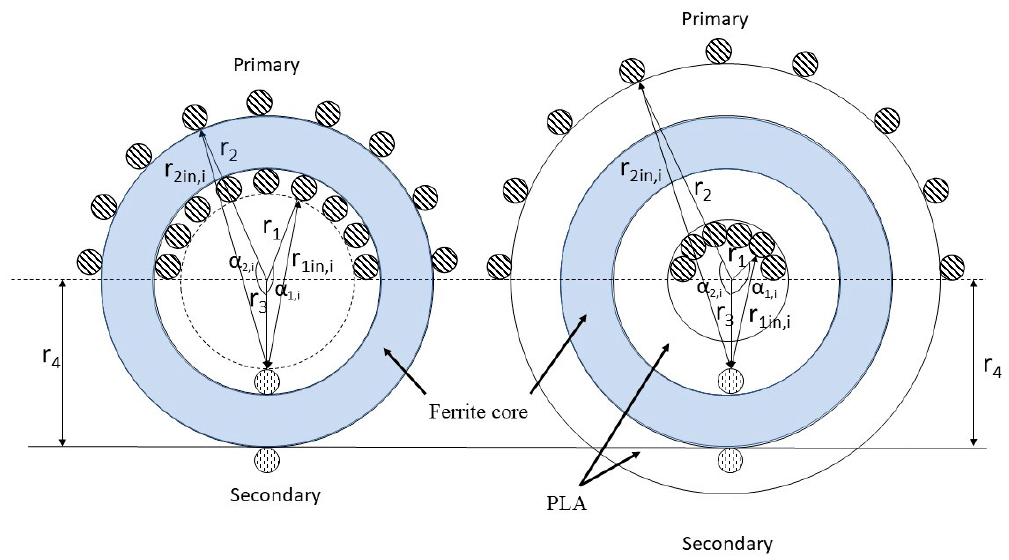
Figure 9. Toroidal transformer with 180° sectored winding, Conceptual presentation of transformer prototypes from left to right conventional and modified. PLA—polylactic acid.